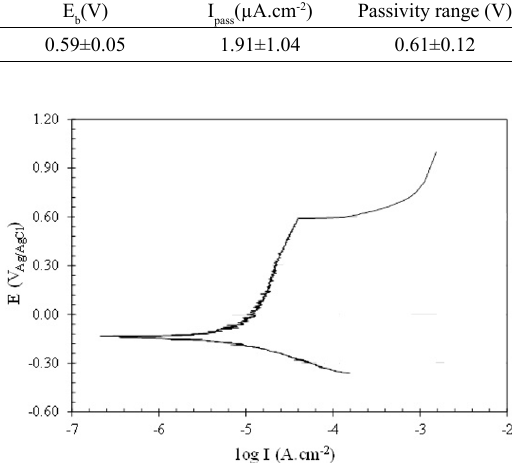
Figure 11. Tafel plot for the AISI 409 stainless steel after 24 h of immersion in 0.1 M NaCl solution at room temperature.